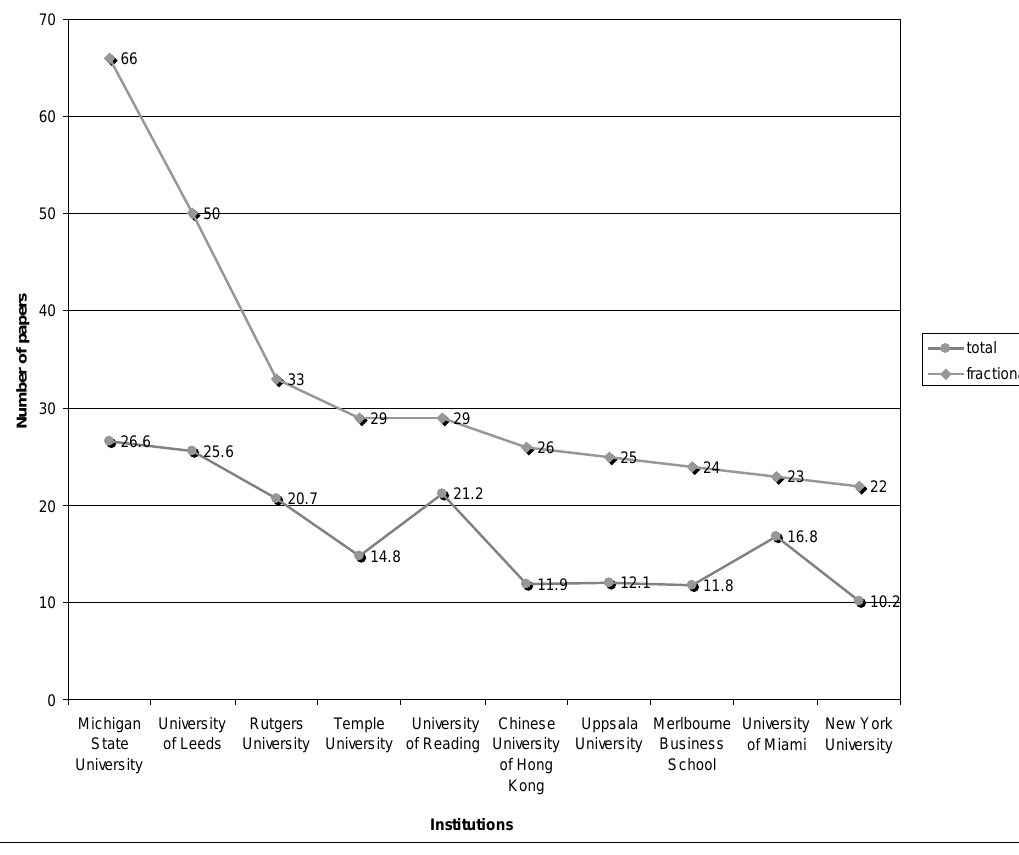
Figure 1. “Number of papers in universities/total or fractional authors”. Source: Adler